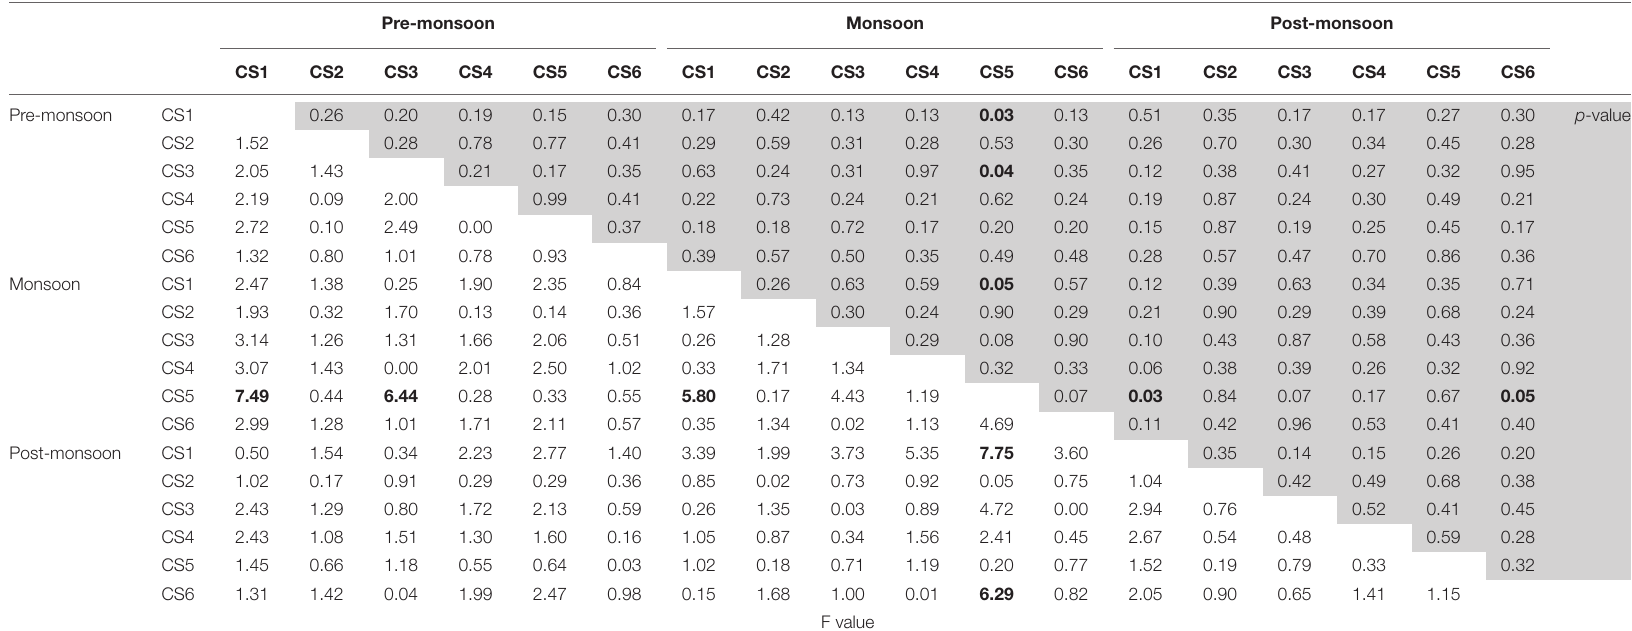
TABLE 3 | Results of ANOVA analysis between all possible combinations of seasonal and station wise total (live + dead) foraminiferal numbers.